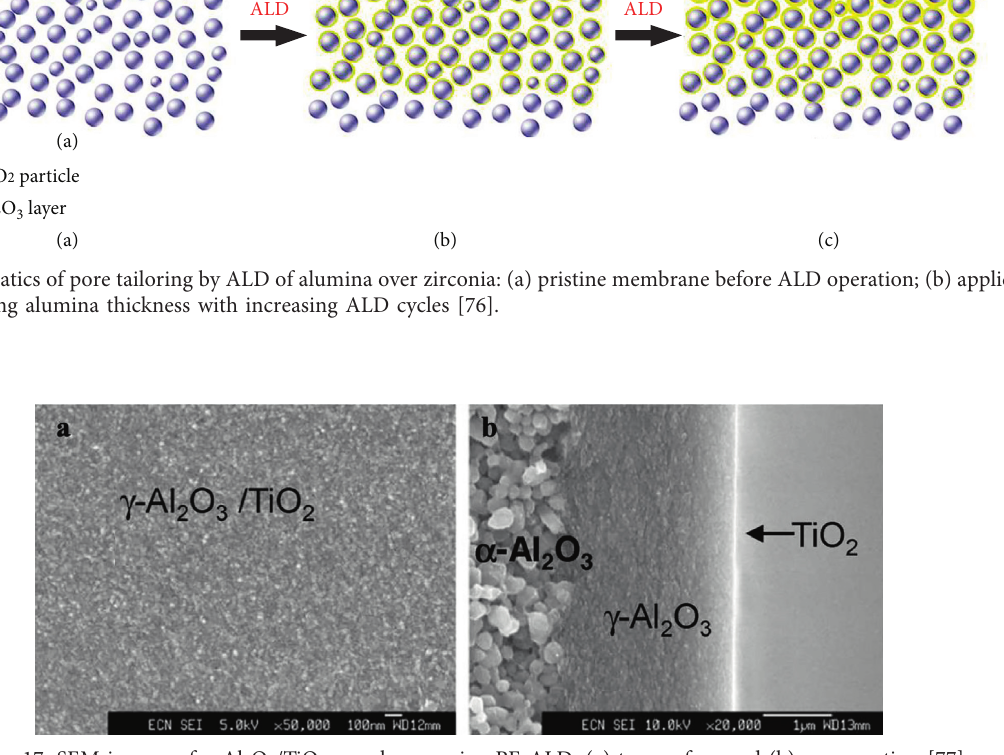
Figure 15: (a) CO 2 flux versus time relation for samples coated with and without CVD at 650 without CVD [34].